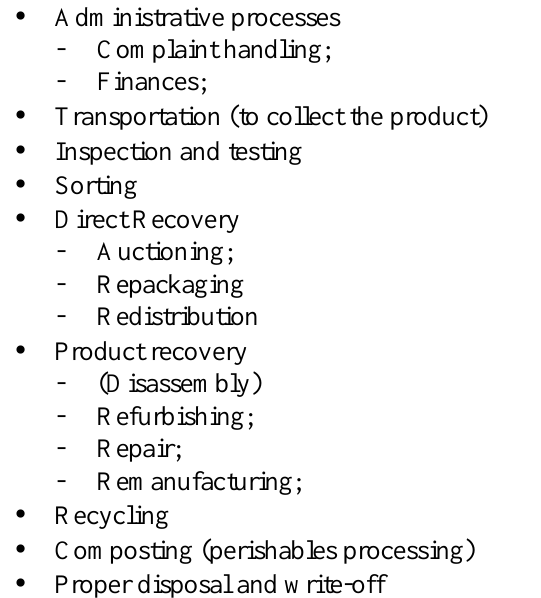
Figure 4. Destination of returned trading goods Recovery is only one of the processes in the reverse logistics chain (see Guide and Wassenhove, 2002). There are other processes, as